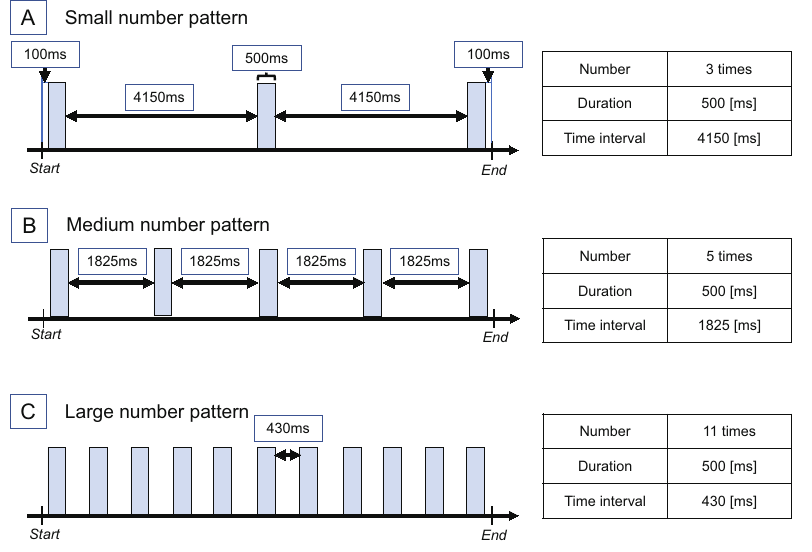
Figure 4. Stimulus pattern of Experiment 1. Three patterns with different numbers of stimuli. Reprinted/adapted with permission from Ref. [11] 2021,